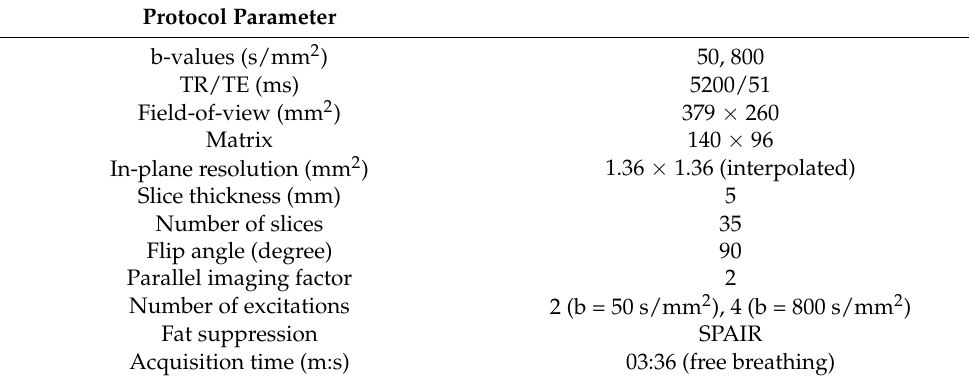
Table 1. Diffusion-weighted imaging